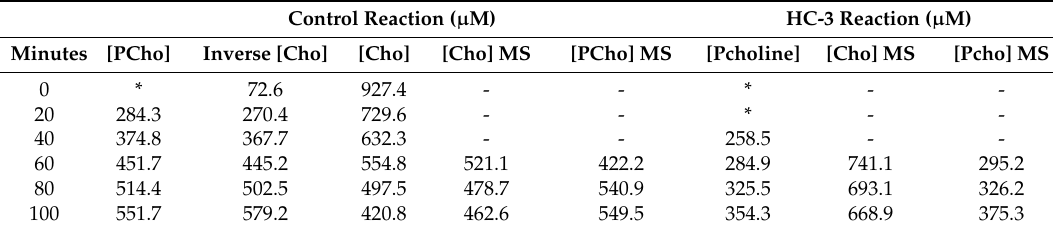
Table 1. Comparisons between PCho and Cho colorimetric measurements, as well as the PCho measurement as inferred from the Cho measurement (inverse [Cho]), from both the control and the HC-3 reactions. Asterisks are shown in places where a calculation could not be made due to limitations in the sensitivity of the MBD method. Bars are shown where measurements were not